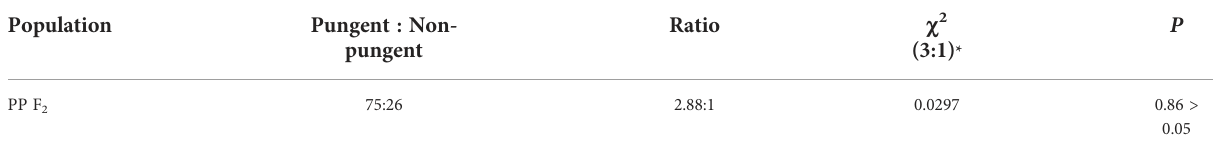
TABLE 4 Segregation ratio of pungency phenotype in the ‘ PP ’ F2 population.